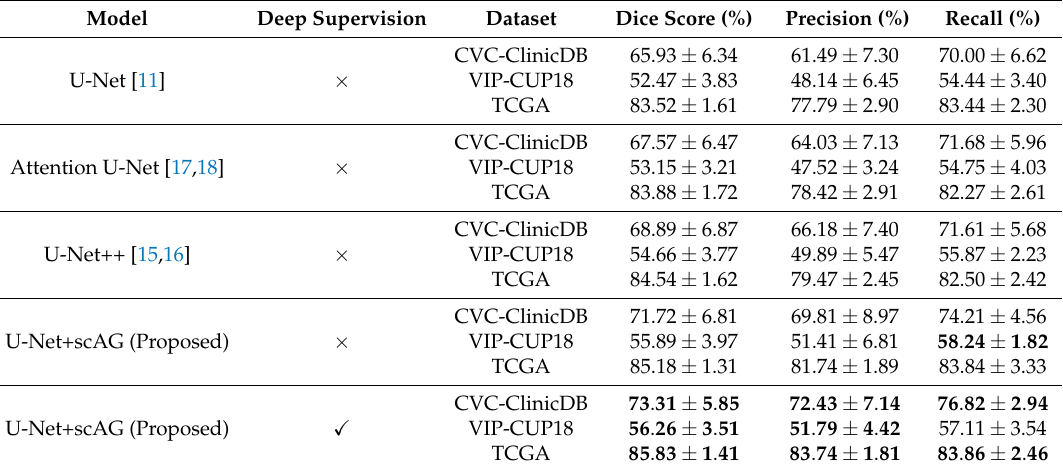
Table 4. Experimental results on three datasets (best results marked bold).